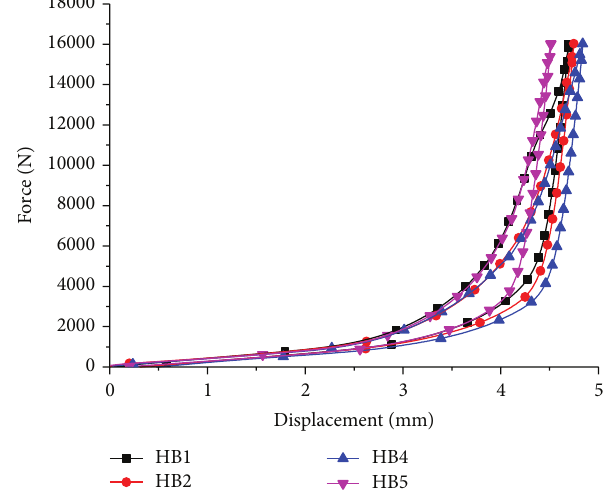
Figure 4: The tests results static characteristics of the HDBs with different internal